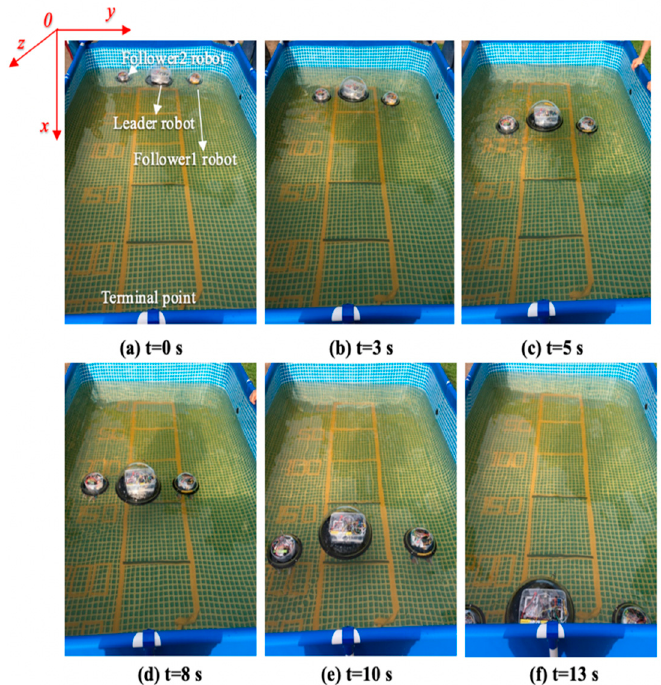
Figure 19. Robots formation experiment with a lateral queue.